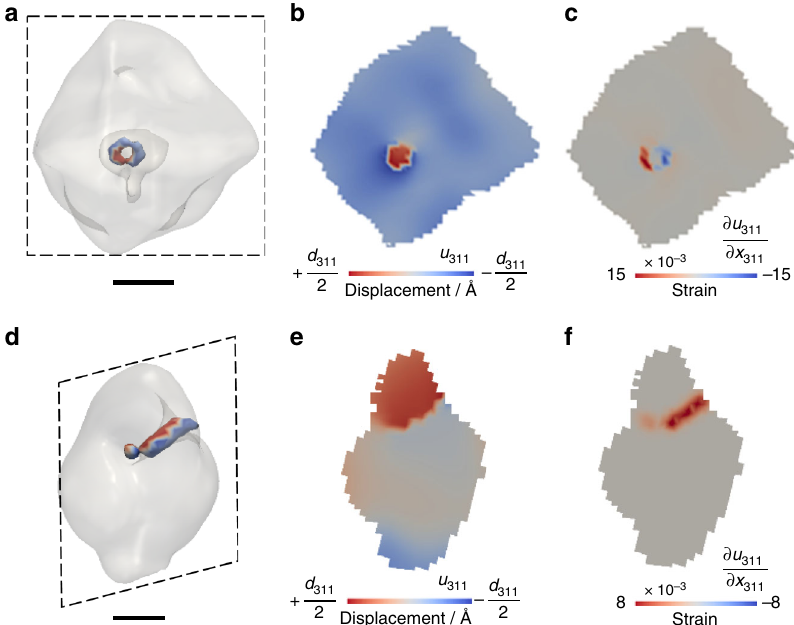
Fig. 4 Dislocation defects observed during the oxidative dissolution of magnetite. a A dislocation loop formed after 1 min reaction in 0.1 M HCl solution of the octahedron-shaped magnetite crystal shown in Fig. 2 with cross-sectional views at the dashed line box showing b displacement and c strain. d A linear dislocation defect formed after 4 min reaction in 0.1 M HCl solution in the magnetite crystal shown in Supplementary Fig. 8 with cross-sectional views at the dashed line box showing e displacement and f strain. Scale bar, 100 nm